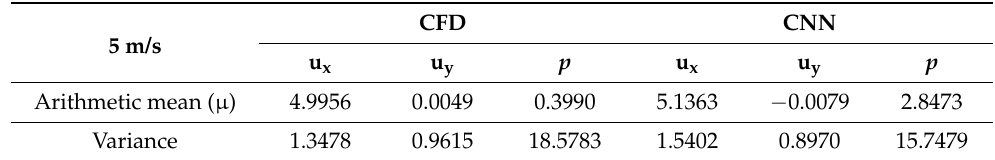
Table 2. Comparison of arithmetic mean and variance between the ground-truth CFD data and the CNN predictions for the streamwise velocity of 10 m/s.